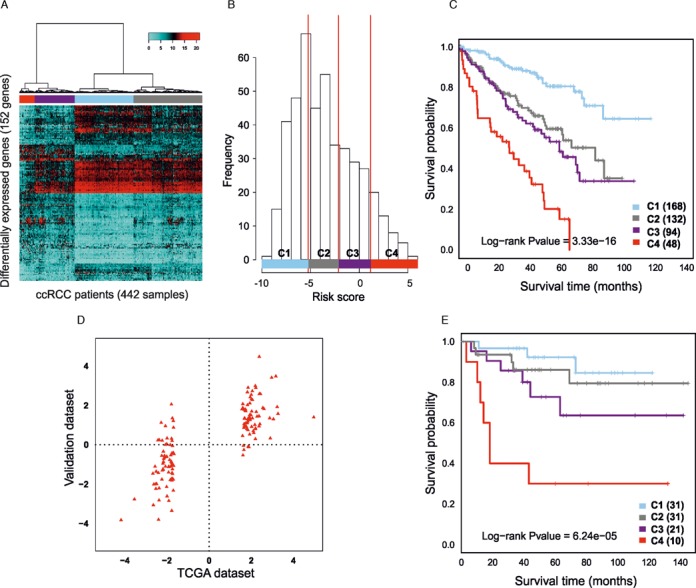
Novel prognostic markers for ccRCC. (A) Unsupervised clustering of the patients (columns) across the genes detected as differentially expressed by ROTS (rows). (B) Distribution of the risk scores across the patients in the TCGA data. The red vertical lines show the cutoffs used to define the four risk categories (−5.10, −2.17, 0.94). The risk categories significantly overlapped with the similarly colored clusters in panel A (69, 92, 78 and 92 percent of overlap with C1, C2, C3 and C4 survival groups respectively; Fisher's exact test P-value < 0.01). (C) Kaplan–Meier curves comparing the survival of the ccRCC patients in the four risk categories in the TCGA data. The numbers in parentheses indicate the numbers of patients in the different risk categories. The colors correspond to the colors in panels A and B. (D) Correlation of the signal log-ratios of the differentially expressed genes (red triangles) between the best and poorest survival patients in the TCGA (x-axis) and validation data (y-axis). Patients with comparable survival times (<12 months, >60 months) were considered in the analysis. A highly significant Pearson correlation of 0.796 was observed (P < 10–15). (E) Kaplan–Meier curves comparing the survival of the ccRCC patients in the four risk categories in the validation data. The highly significant association between the risk score categories and survival verify the risk score model developed using the TCGA data.